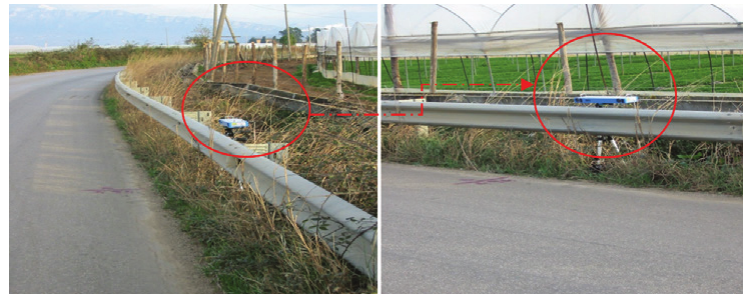
Fig. 3. Detection device for collection